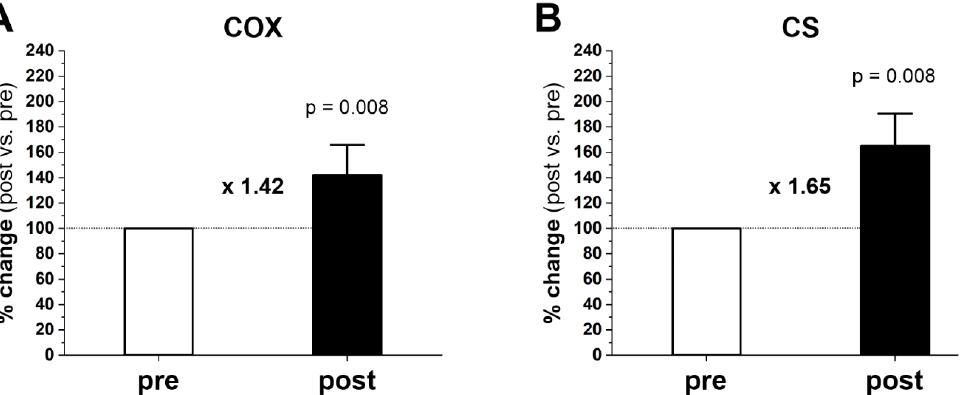
Figure 4. Training-induced changes in maximal cytochrome c oxidase (COX) activity ( A ) and maximal citrate synthase (CS) activity ( B ) in the human gastrocnemius muscle, studied at 37 °C. The results are expressed as a percentage of changes after training (post) in relation to the pretraining status (pre). Data are presented as the mean ± SD. The nonparametric Wilcoxon sign rank test with a two-sided p-value is shown. Post- vs. pre-fold changes defined as the ratio of post-training value to pretraining value are marked as a multiple of the change, e.g., × 1.42 is a 1.42-fold increase.